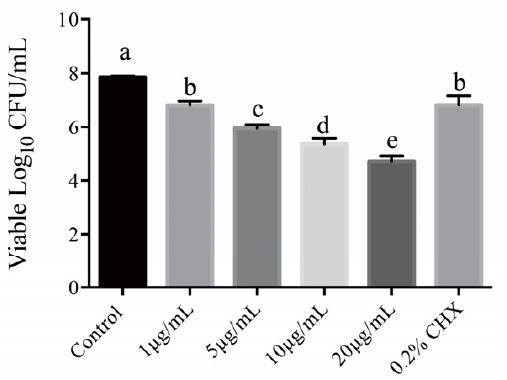
Figure 6. Colony-forming units of living microorganism on dentin slices after different treatments. Values with dissimilar letters indicated significant difference between two groups ( p <